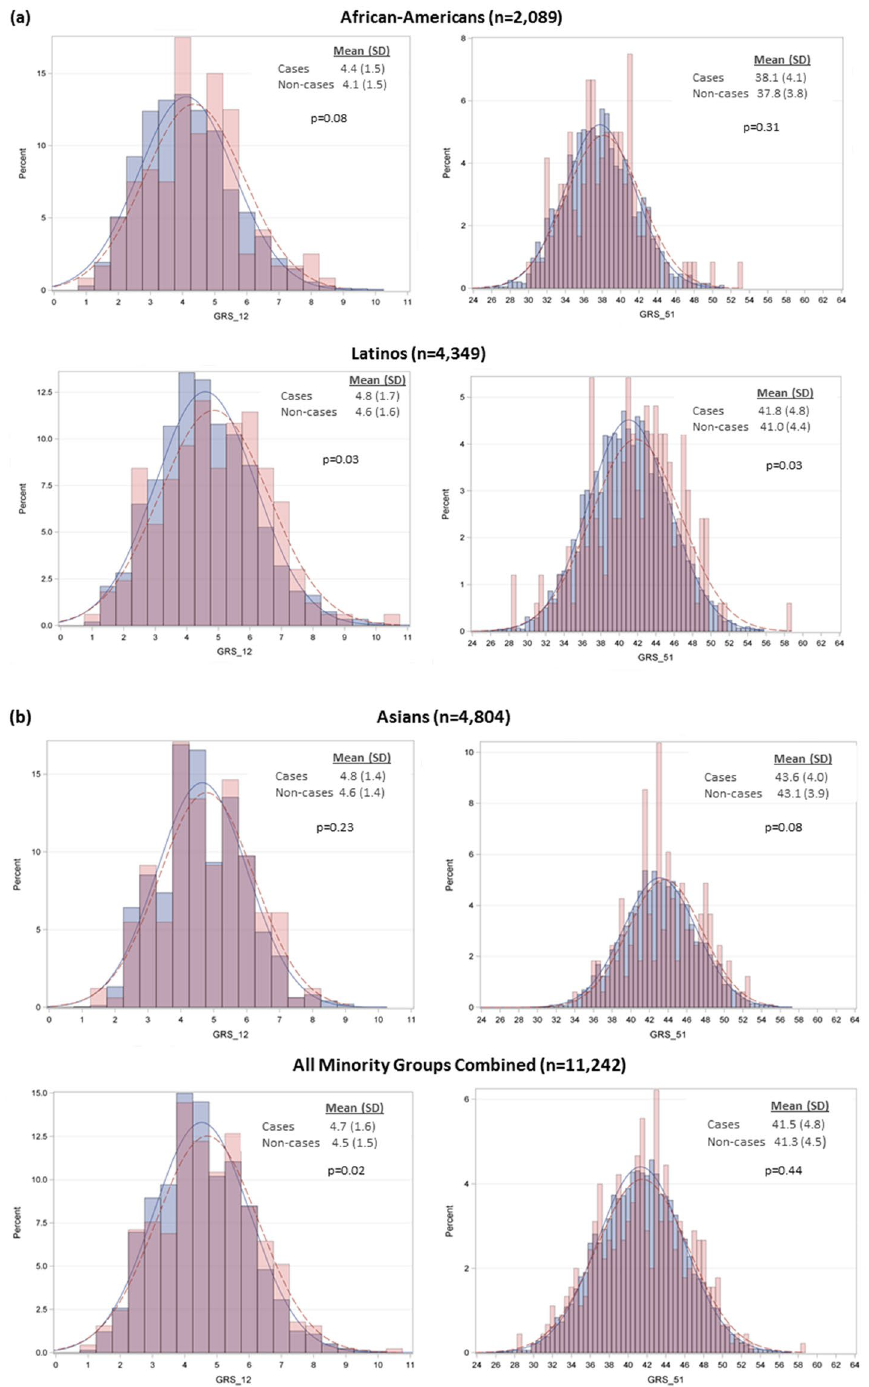
Figure 1. Distributional properties of GRS_12 and GRS_51 in the three race/ethnic groups. CHD cases are depicted in red, non-cases in